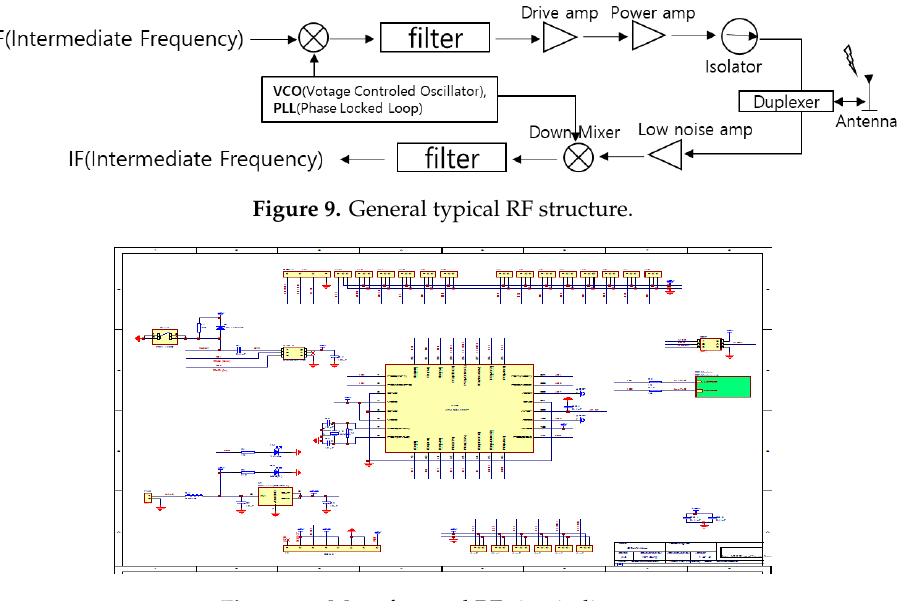
Figure 10. Manufactured RF circuit diagram.